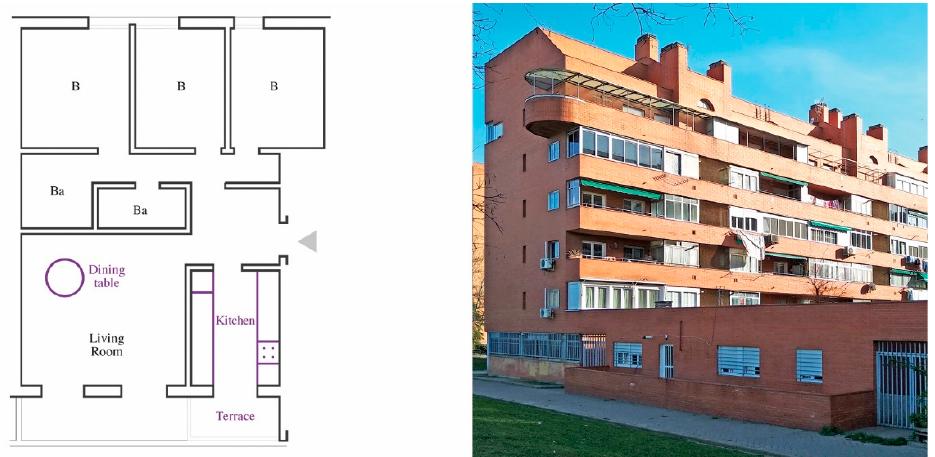
Figure 9. Houses along Palomeras Park, UD 8 mega-block. Three-bedroom apartment. Plan redrawn and photo by author.